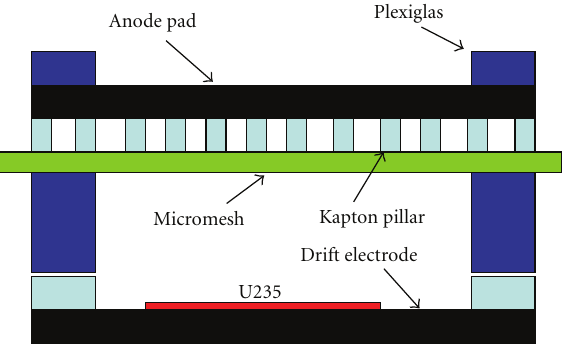
Figure 1: Detail of the MMGAS detectors.